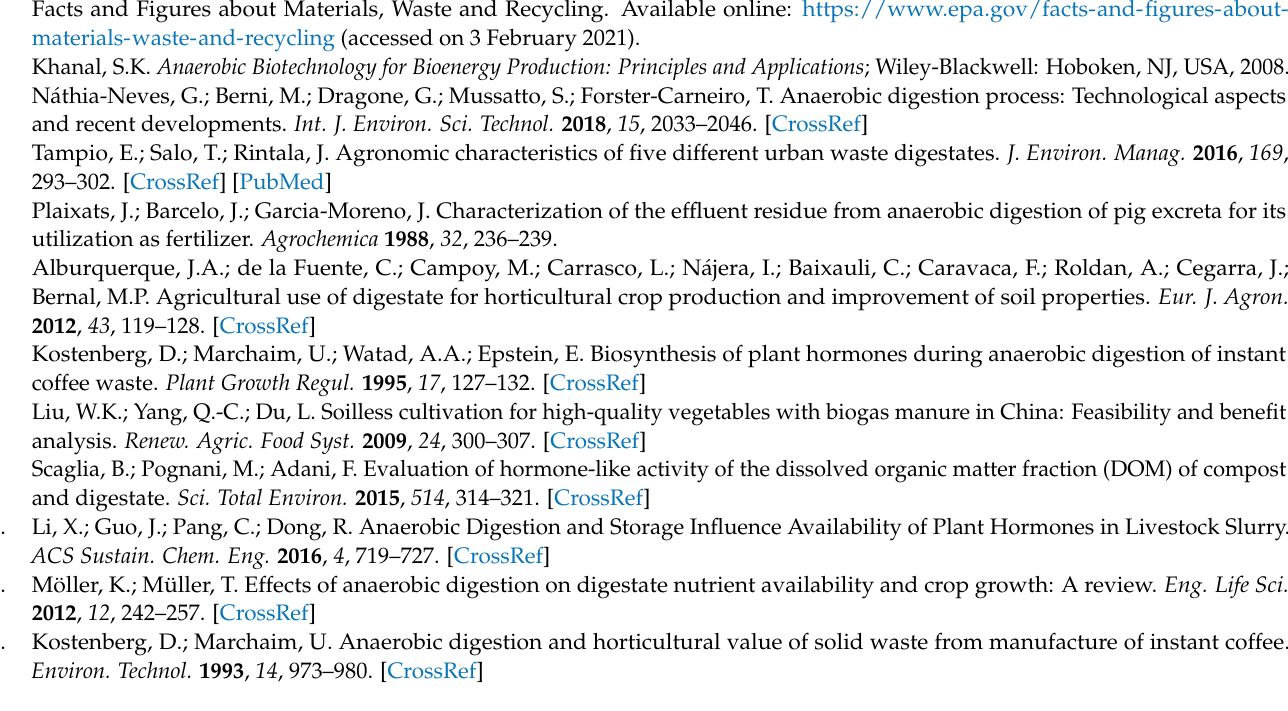
Supplementary Materials: Raw data used to generate tables and figures in the Results section are available online, at https://www.mdpi.com/2073-4395/11/3/509/s1. Supplemental Data Tables: Table S1: Digestate Treatment Effects on Shoot Dry Weight (Figures 1 and 2); Table S2: Digestate Tratment Effects on Root Length over Time (Figures 3 and 4); Table S3: Digestate Treatment Effects on Nitrogen, Phosphorus and Potassium RE (Figure 5); Table S4: Digestate Treatment Effects on Electrical Conductivity of Planting Media and Sodium in Plant Tissue (Figure 6); Figure S1: Pearson Correlation Plot for Sodium and Dry